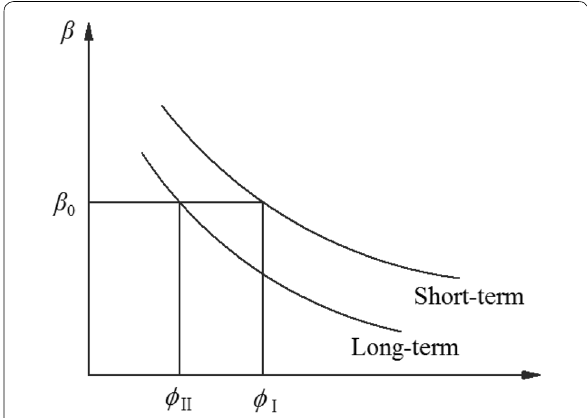
Fig. 1 β – φ curves from the Canada reliability analysis